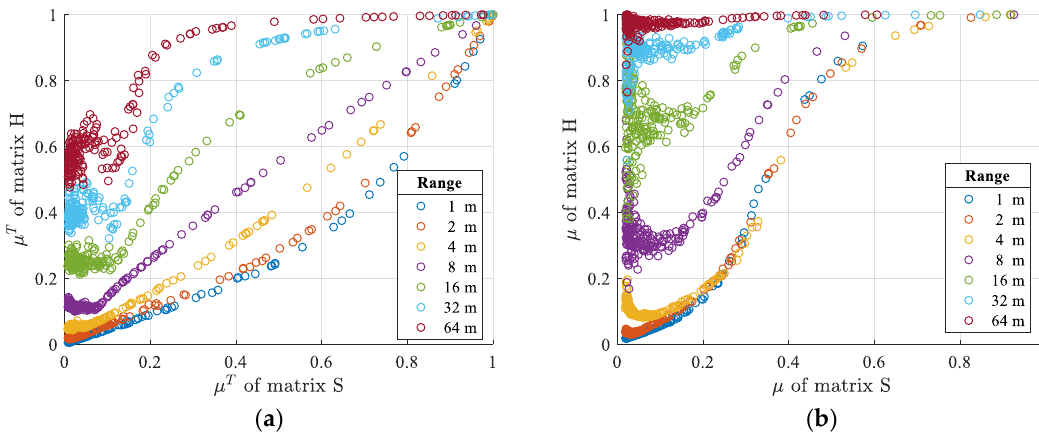
Figure 4. The coherence relationships obtained in the third numerical simulation via Monte Carlo method: ( a ) µ T ( H ) ← µ T ( S ) and ( b ) µ ( H ) ← µ ( S ) . The sources are modulated by random spatial frequencies.